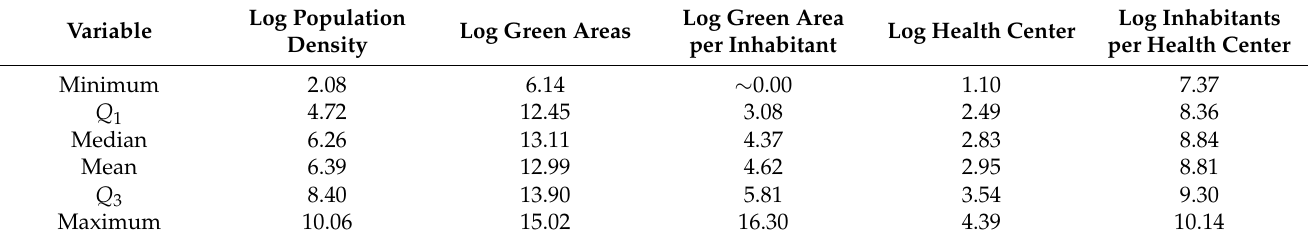
Table 2. Demographic variables summary